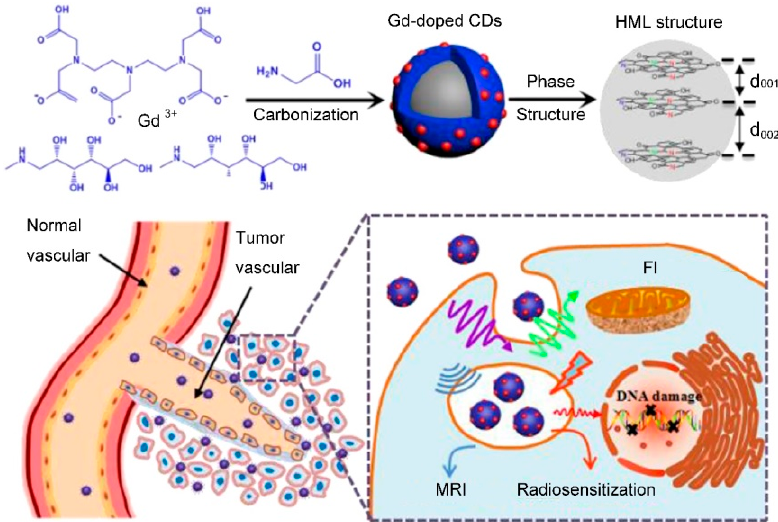
Figure 5. Schematic synthesis and application of Gd-doped CDs through one-pot pyrolysis of glycine and Gd-DTPA at 180 ° C (adapted from Zou et al. 2017 [58], Copyright 2017 The Elsevier Ltd. and reproduced with permission).